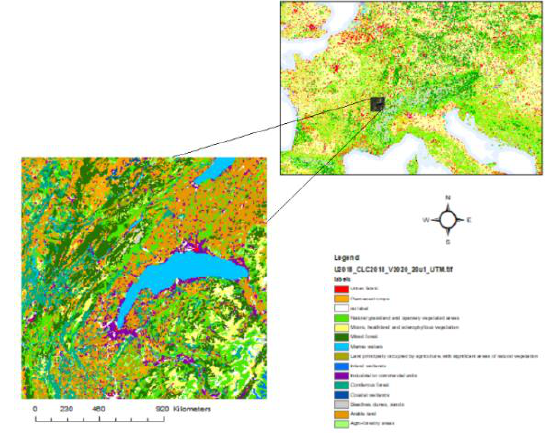
Figure 4 . Ground truth for first data